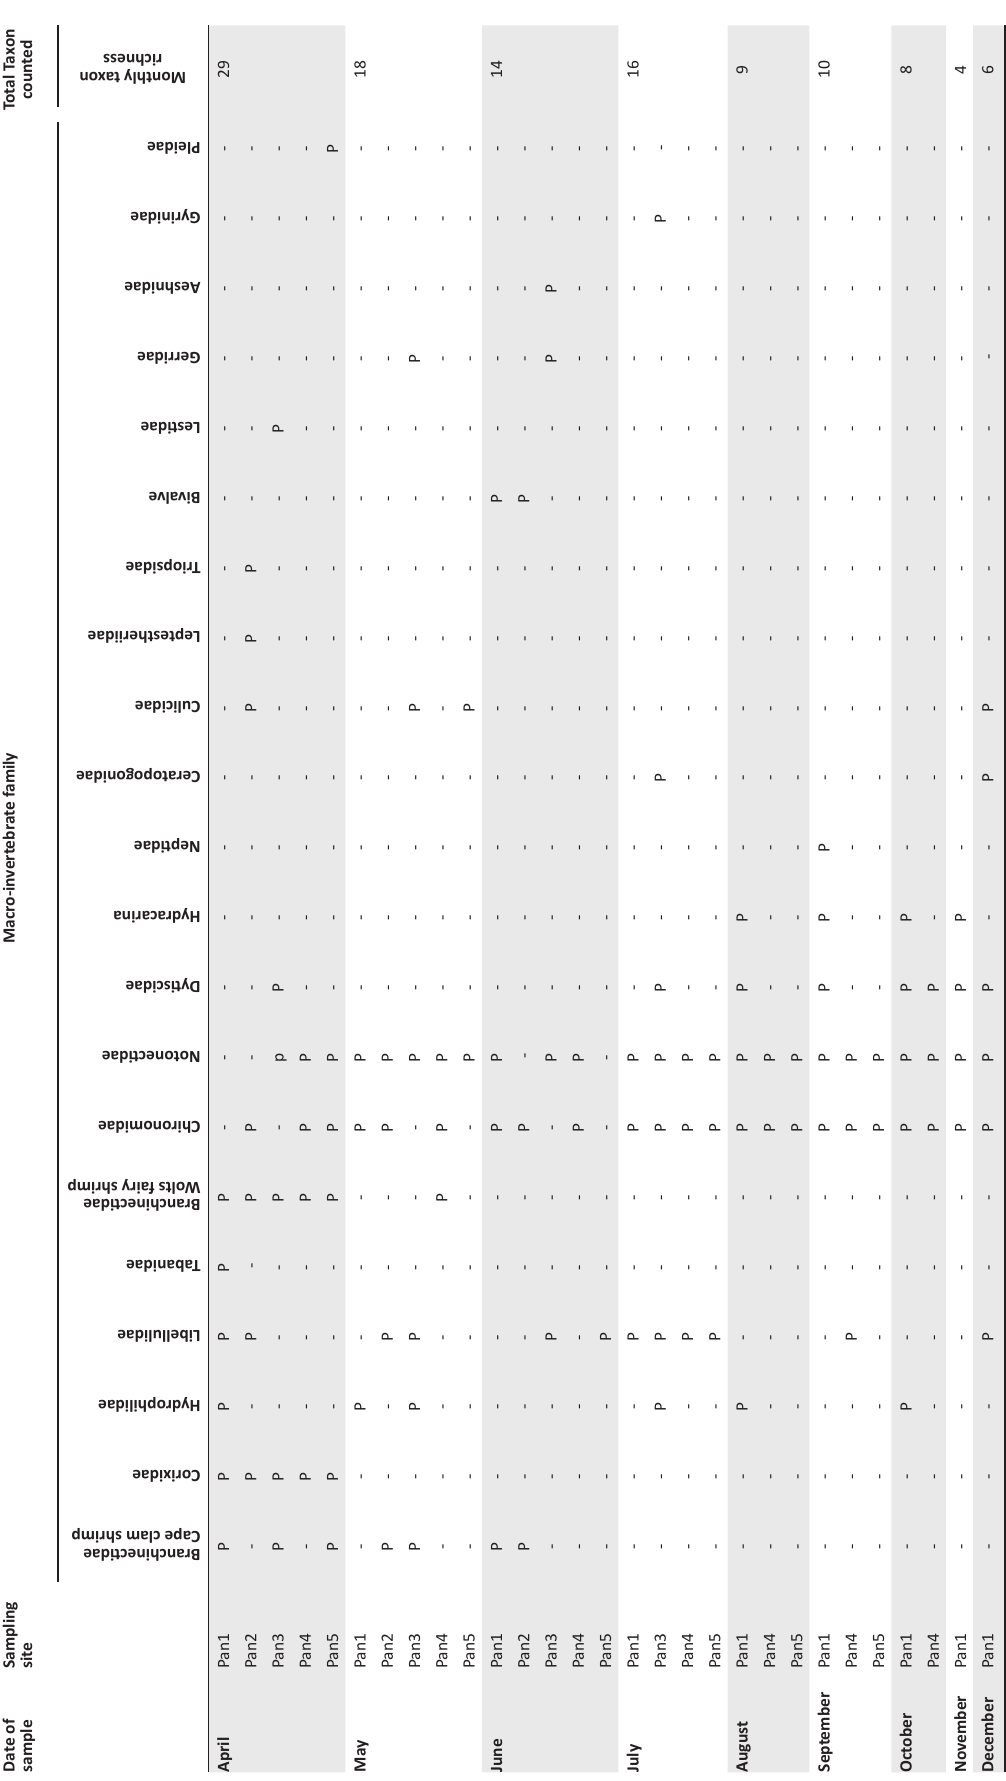
Branchinectidae